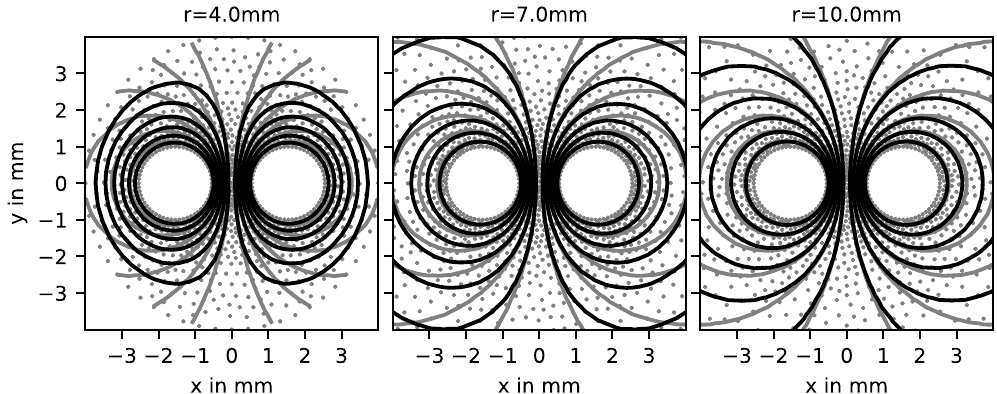
Figure 10. Equipotential lines of Φ of a two-wire line for different boundary radii. Numerical solution with the Dirichlet boundary condition ( black ), and the analytical solution ( gray ).